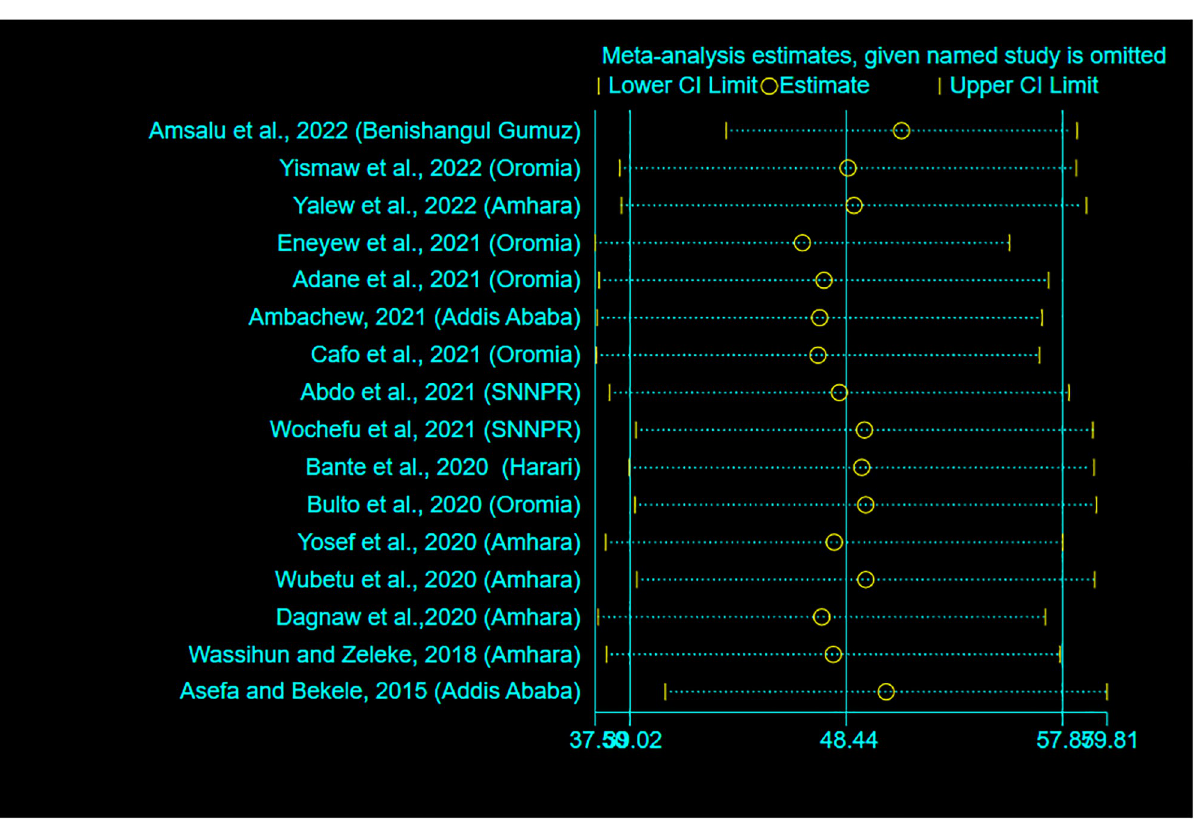
Fig 6. Sensitivity analysis for the pooled prevalence of RMC in Ethiopia,